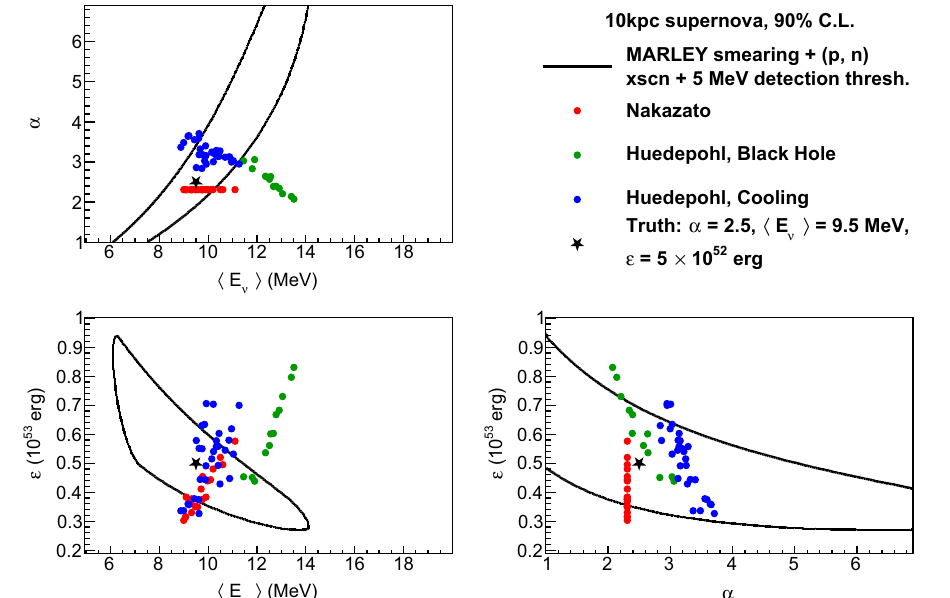
Fig. 15 Sensitivity regions for the three pinched-thermal parameters (90% C.L.). The black star represents the assumed true parameters. SNOwGLoBES assumes a cross section model from MARLEY, real- istic detector smearing from LArSoft, and a step efficiency function with a 5-MeV detected energy threshold, for a supernova at 10 kpc. Superimposed are parameters corresponding to the time-integrated flux